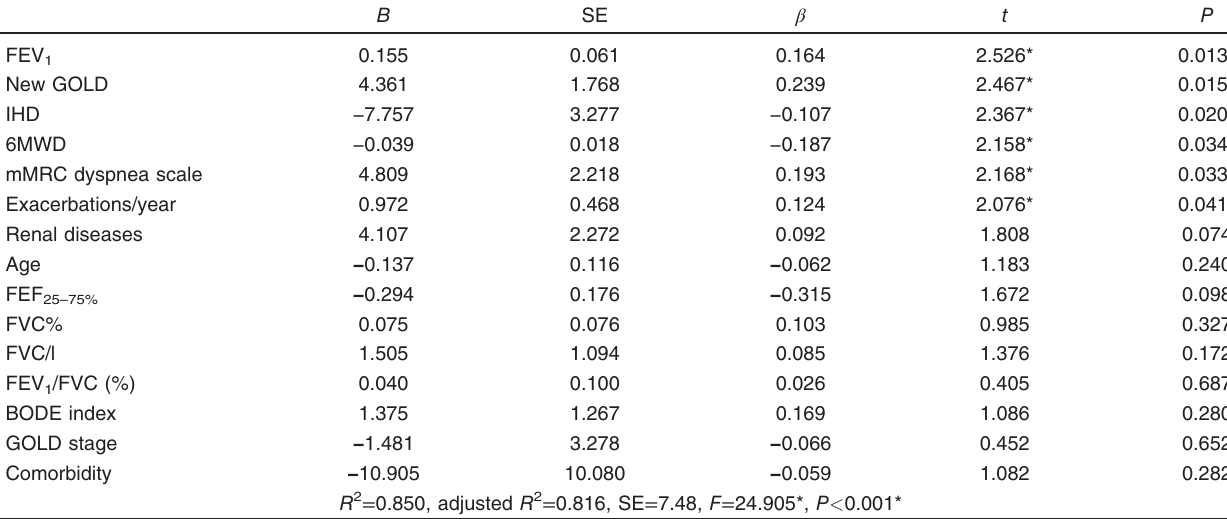
Table 4 Multivariate linear regression for factors affecting St George ’ s Respiratory Questionnaire